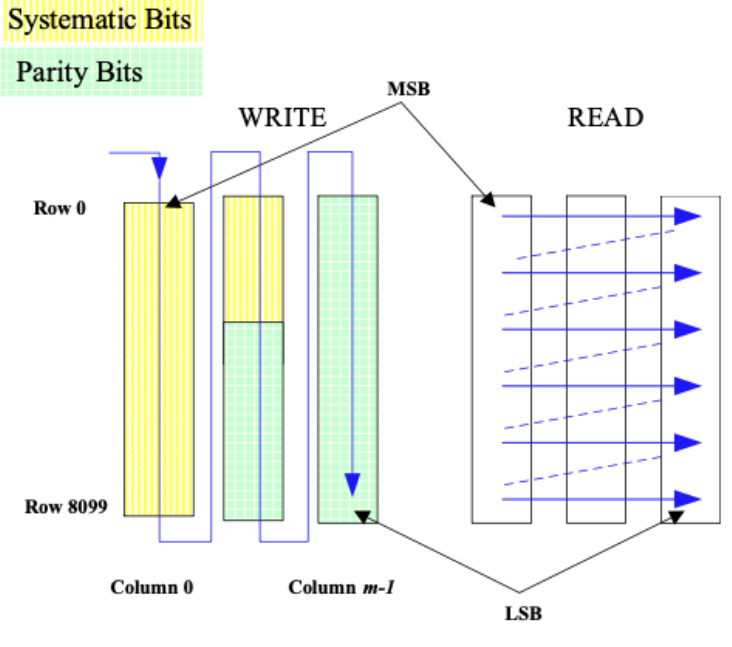
Figure 6. Bit-interleaving scheme.